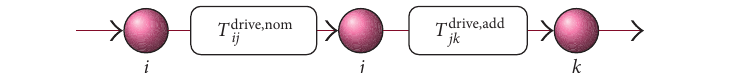
Figure 6: Network representations of the two activities representing driving through a section. At node i , a nominal driving activity is initiated. At j , an additional (iterative) driving activity is initiated to account for any adjustment of the initial